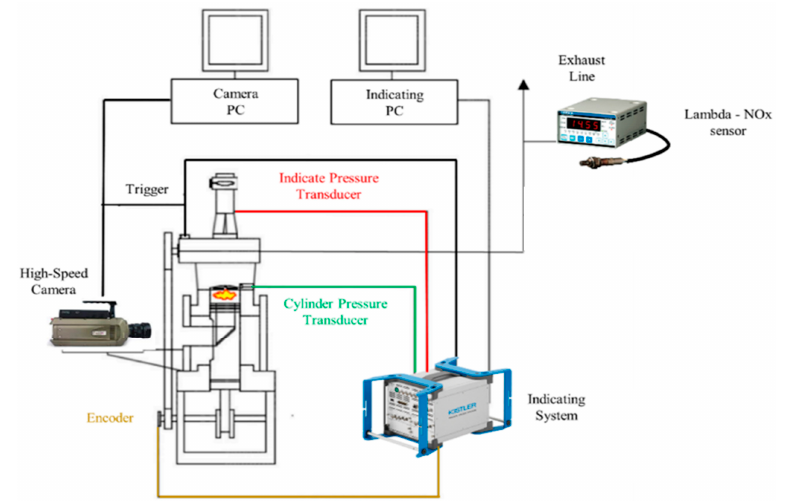
Figure 1. Experimental apparatus.